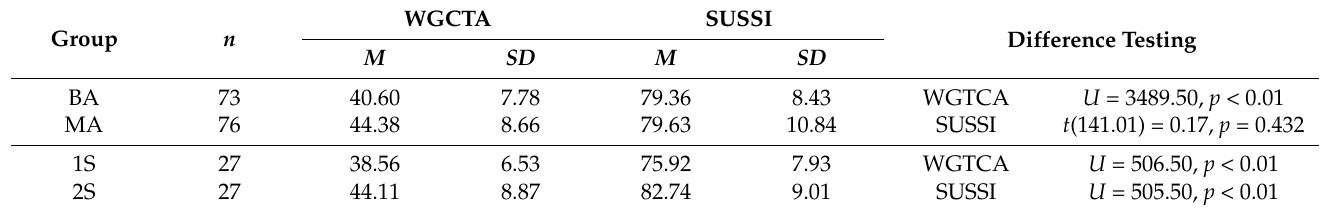
Table 4. Results of difference-testing analyses regarding CT skills and NOS beliefs.